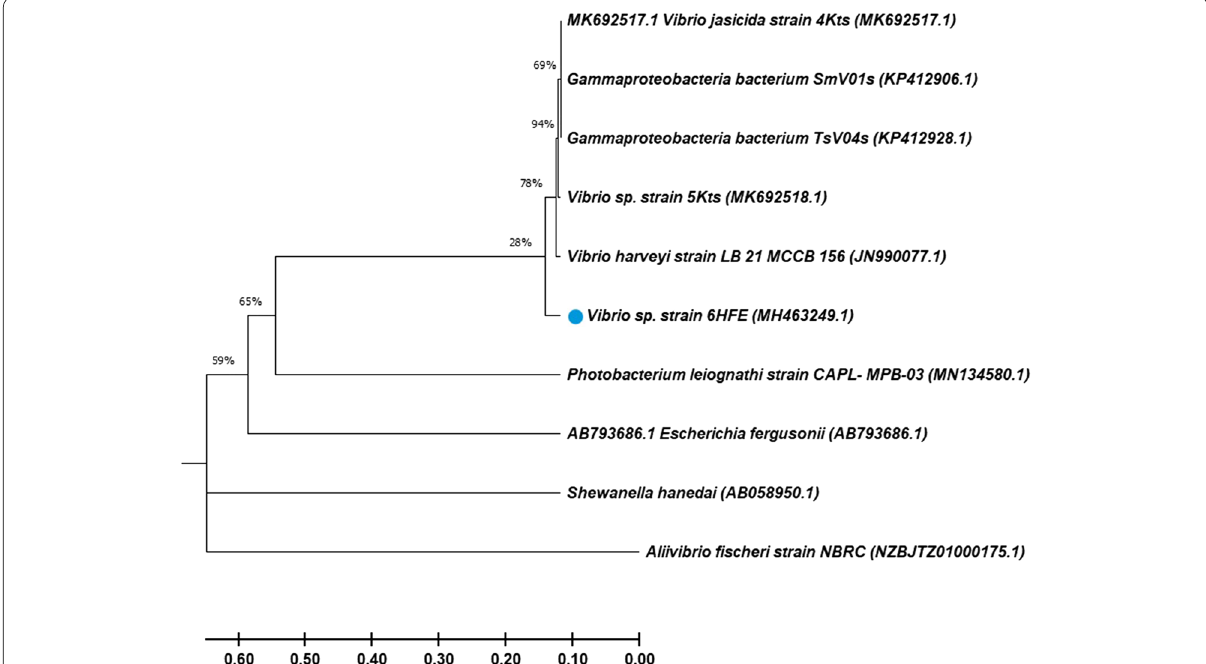
Fig. 1 16S rDNA‑based dendrogram showing the phylogenetic position of strain Vibrio sp. 6HFE among representative of related bacterial